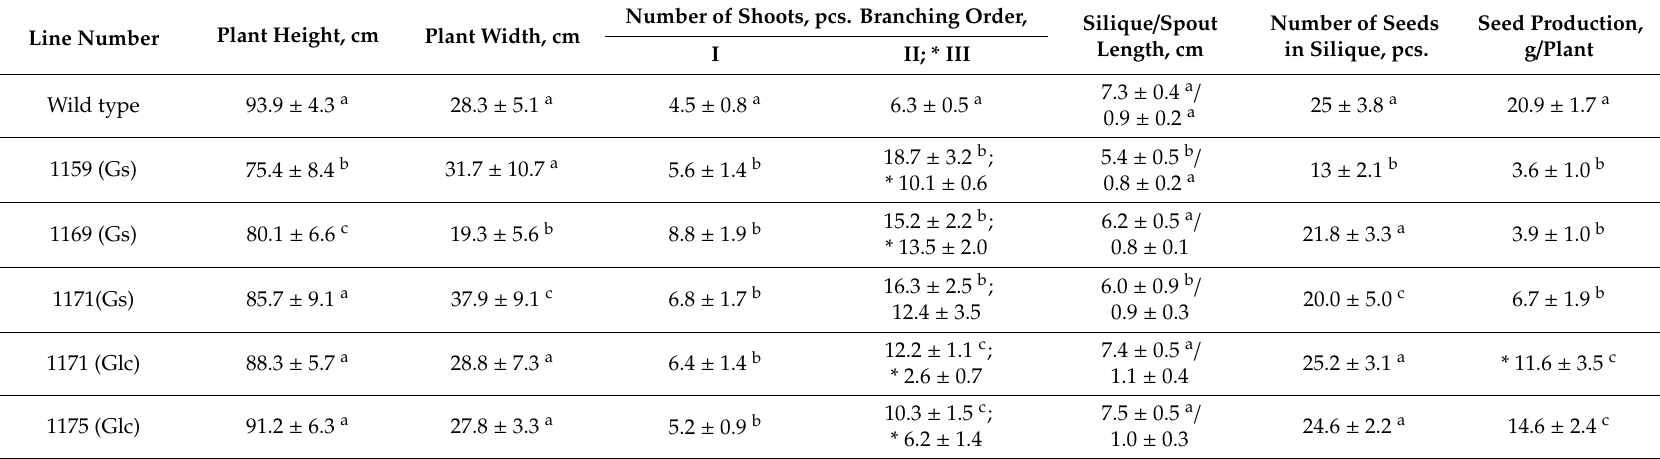
Table 2. Quantitative traits of wild type and mutant glossy (Gs) and glaucous (Glc) plants from M 5 mutant lines. Line